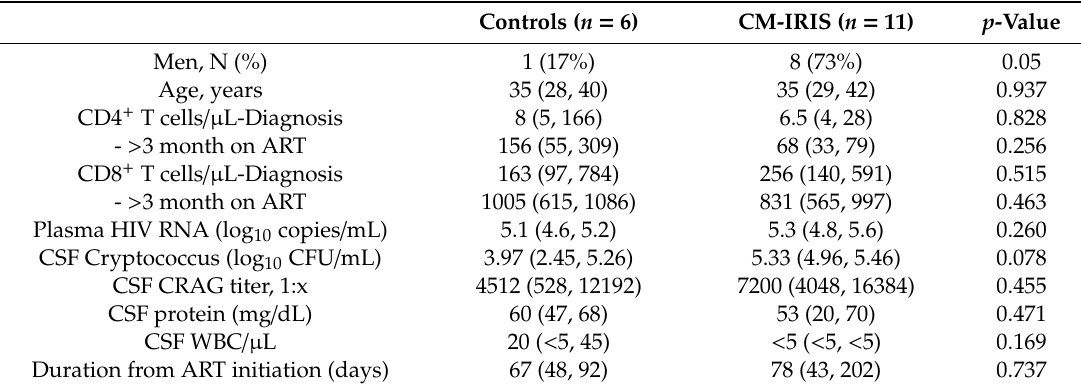
Table 1. Characteristics of subjects who developed cryptococcal meningitis (CM)-immune reconstitution inflammatory syndrome (IRIS) vs. subjects without